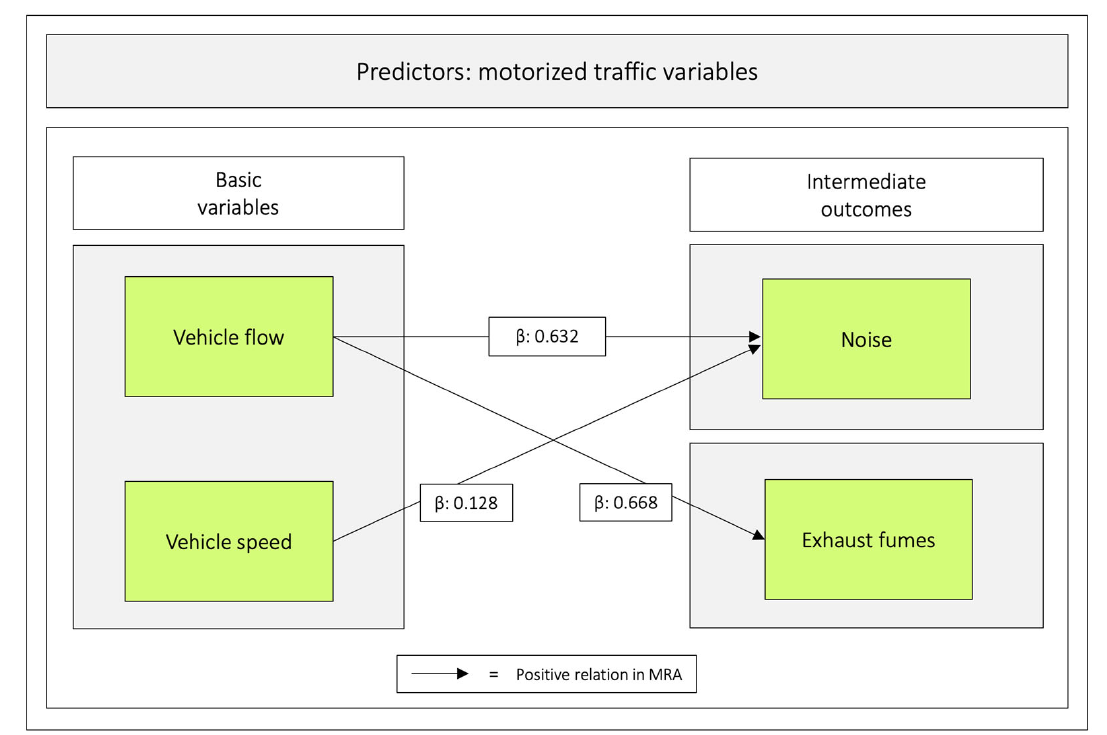
Figure 6. Regression coefficients between vehicle speed and vehicle flow in relation to noise and exhaust fumes . Notes: β = unstandardized beta. The figure is based on Table 6.